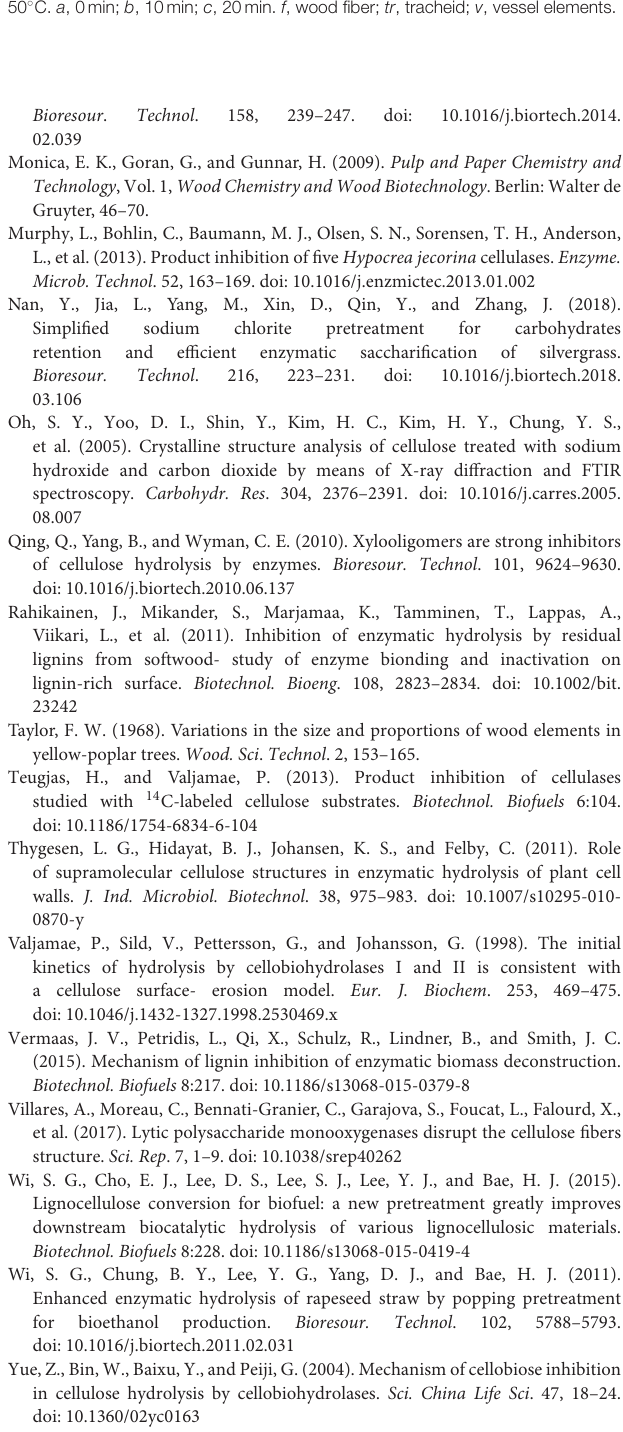
Supplementary Figure 1 | The wood and tracheid fibers, remained on the 60 mesh, were hydrolyzed with 15 FPU mL − 1 in Tissue Culture Plate 96 well at 50 ◦ C.